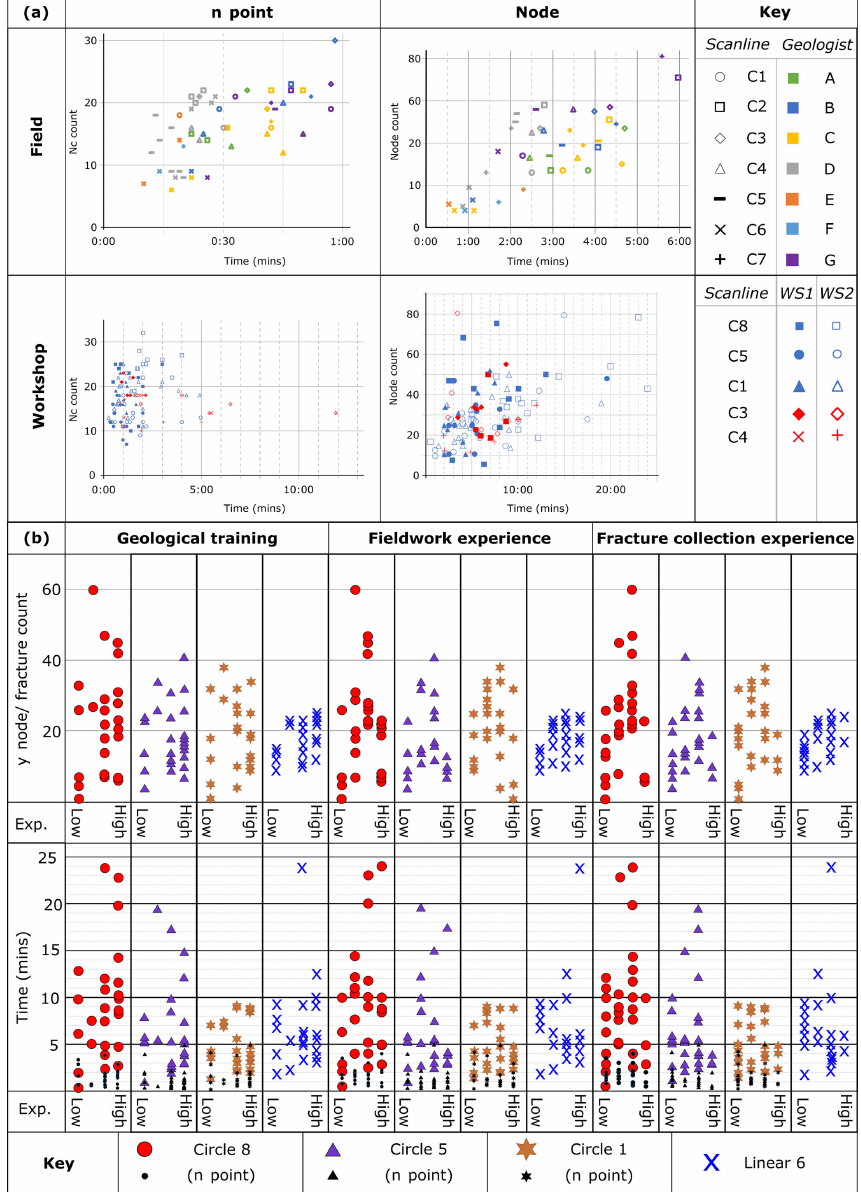
Figure 8. The impact of participant experience on the collection of fracture data. (a) The time taken in seconds to record fracture data ( n and node counts) from circular scanlines both in the field and workshops. (b) The impact of experience on the recorded y count and number of fractures in individual scanlines and the time taken to complete the workshop